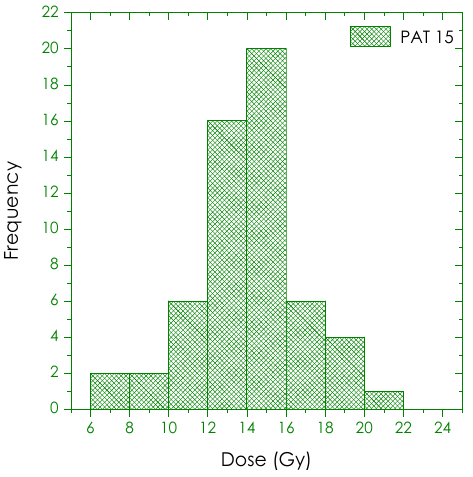
Figure 6. Sample “Pat15.” Distribution of absorbed doses.